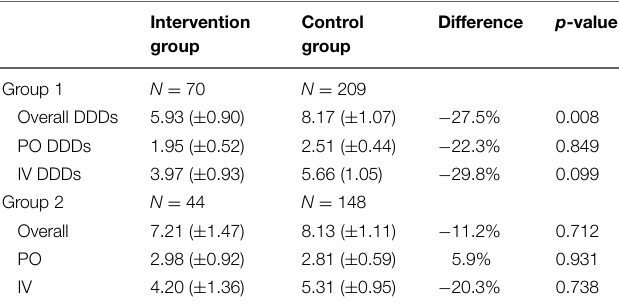
TABLE 2 | Effects of the Antimicrobial Stewardship-Team (A-Team) interventions on antibiotic use (DDD per patient). Intervention Control Difference p group group